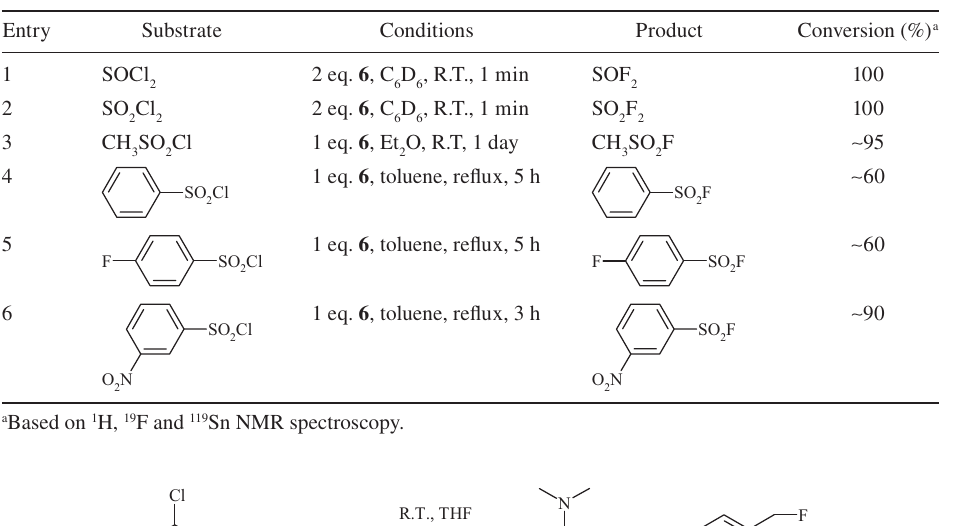
Table 6 Fluorination experiments of thionyl chloride, sulfuryl chloride and some organosulfonyl chlorides.